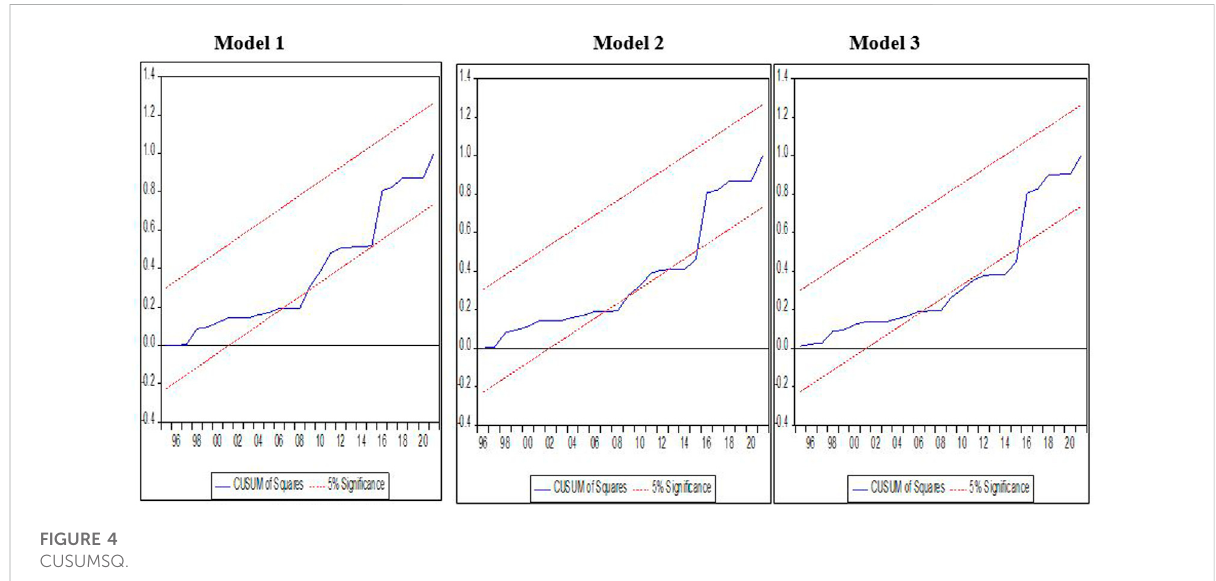
FIGURE 4 CUSUMSQ.